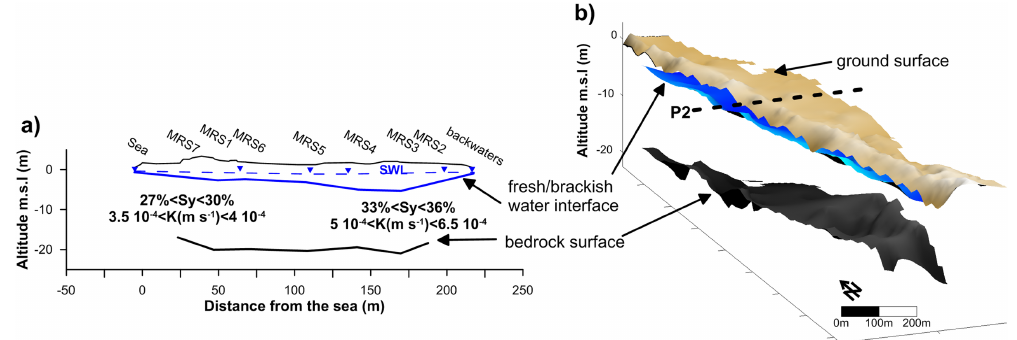
Fig. 7. 2–3-D representation of geophysical results (before the monsoon). (a) 2-D section of Profile P2. SWL is the static water level measured in piezometers. (b) 3-D map of the aquifer.